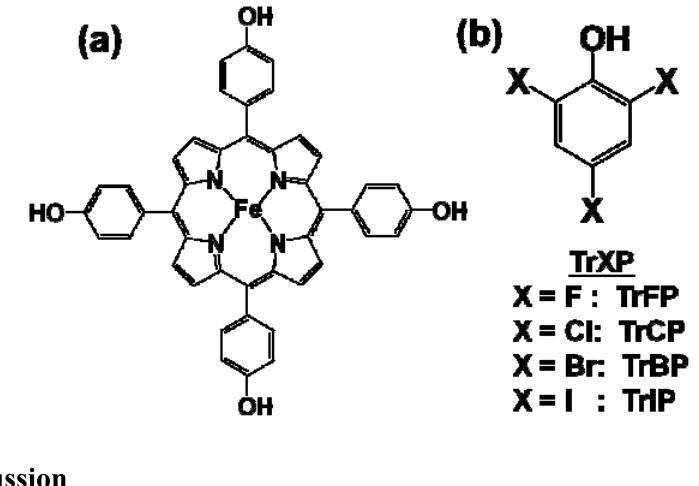
Figure 1. Chemical structures of ( a ) iron(III)-5,10,15,20-tetrakis( p -hydroxyphenyl) porphyrin (FeTHP); and ( b ) 2,4,6-trihalogenated phenol (TrXP).